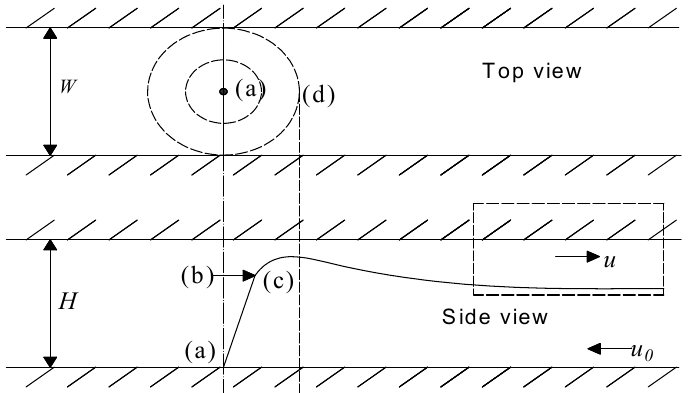
Figure 1. Tunnel fire smoke development process. (a) To (b) is the axisymmetric plume stage. (b) To (c) is the ceiling jet stage. (c) To (d) is the stage when the smoke layer hits the side wall of the tunnel.